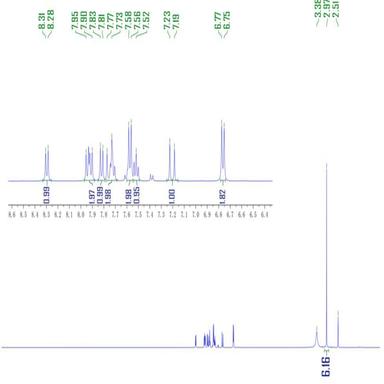
1 NMR spectrum of DADMQ crystal in CD3OD.